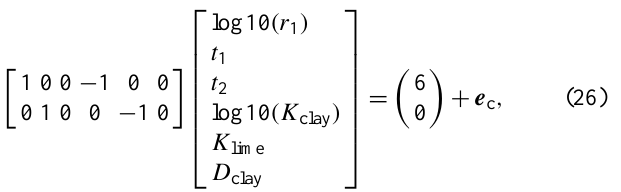
, are listed in Table 2. 4 c